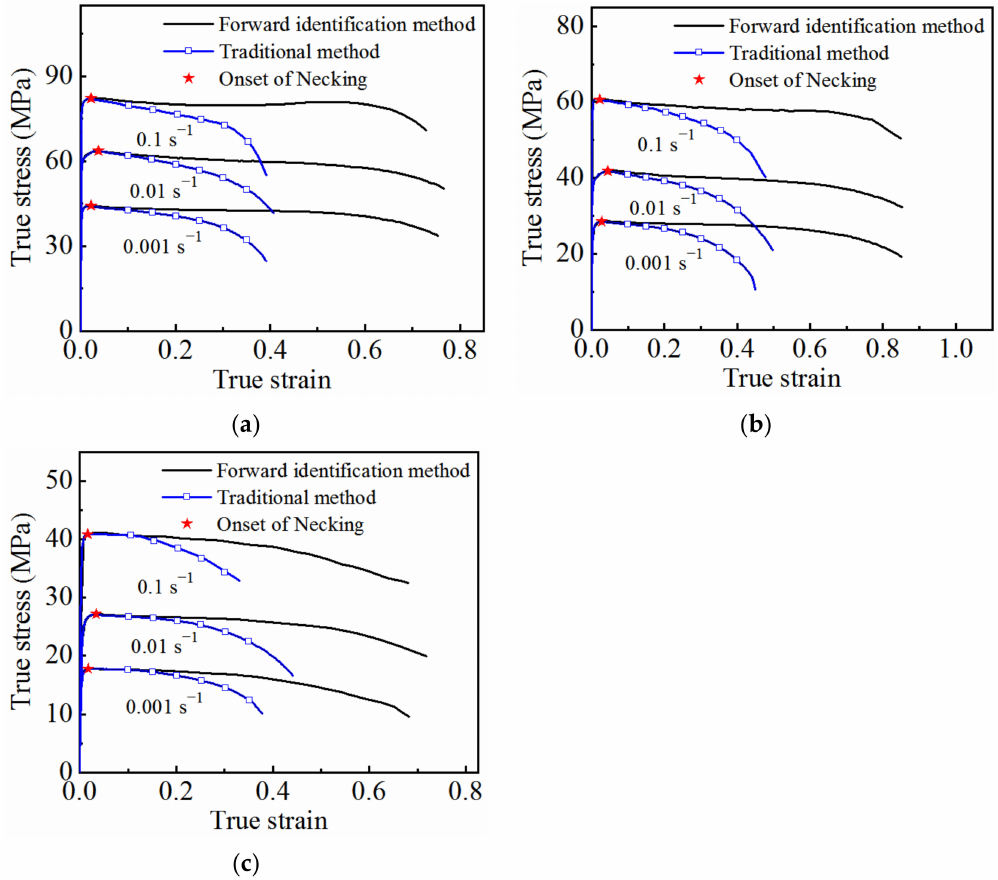
Figure 12. Modified equivalent stress–strain curve of 7075 aluminum alloy under different deforma- tion conditions: ( a ) 350 ◦ C; ( b ) 400 ◦ C; ( c ) 450 ◦